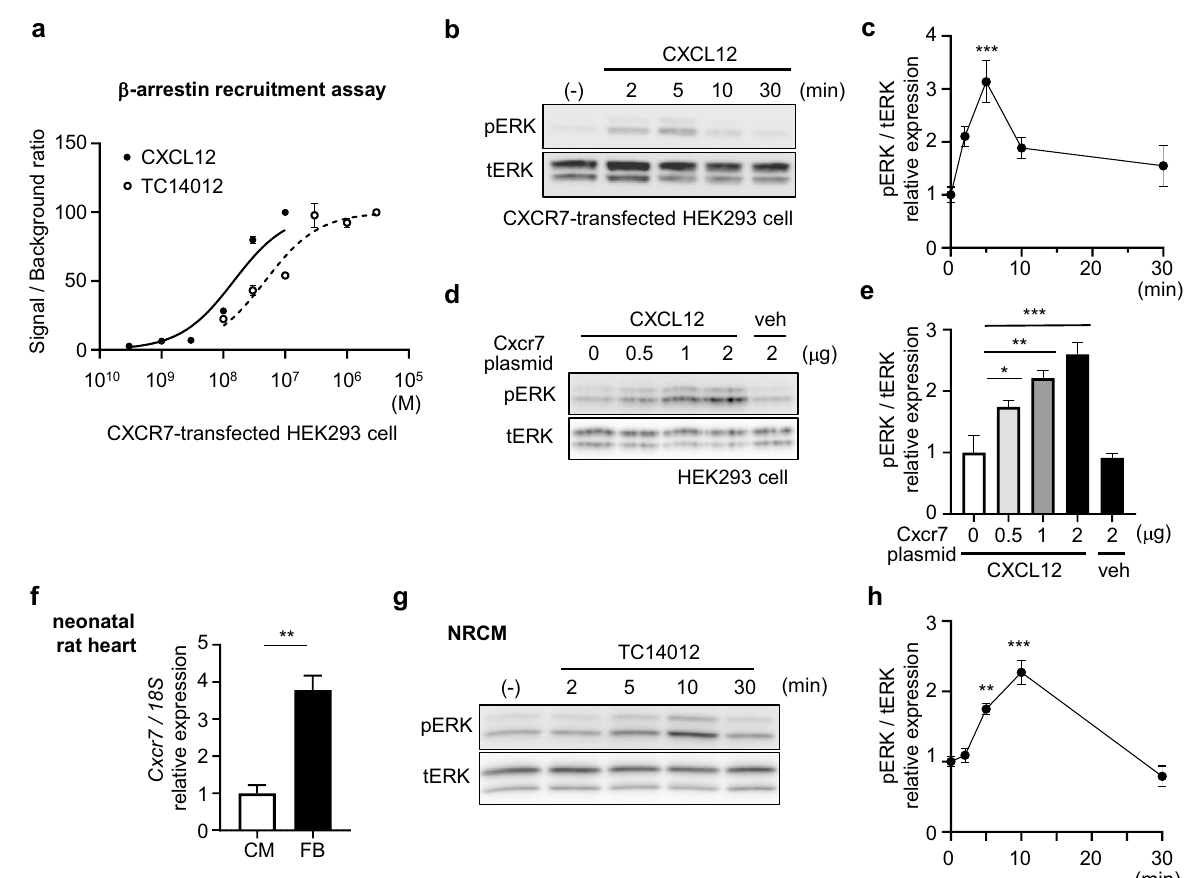
Figure 3. ERK is activated through CXCR7 in cardiomyocytes. ( a ) β-Arrestin recruitment assay of CXCR7 showing that CXCL12 and TC14012 induce coupling of CXCR7 with β-arrestin in a dose-dependent manner (EC 50 : 14.8 nM and 47.4 nM, respectively). Replicate samples are derived from independent HEK293 cells (n = 3). Data are shown as the mean ± SEM. ( b ) Immunoblot analysis of phosphorylated ERK (pERK) and total ERK (tERK) in HEK293 cells transfected with a CXCR7 expression plasmid at various time points after stimulation with CXCL12 (100 nM). ( c ) Quantitative data of the results shown in ( b ). n = 4. Data are shown